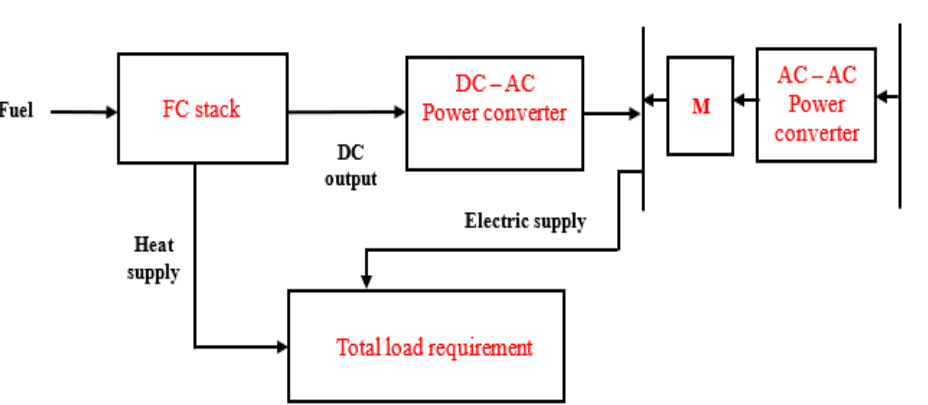
Figure 4. Grid-parallel application of FC power for residential loads.